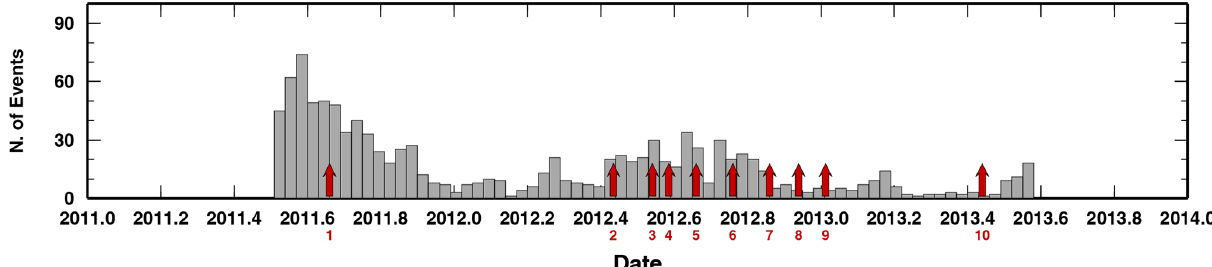
Figure 7. Comparison between the seismicity rate (grey histogram) and the time occurrences for each changepoint (red arrows and